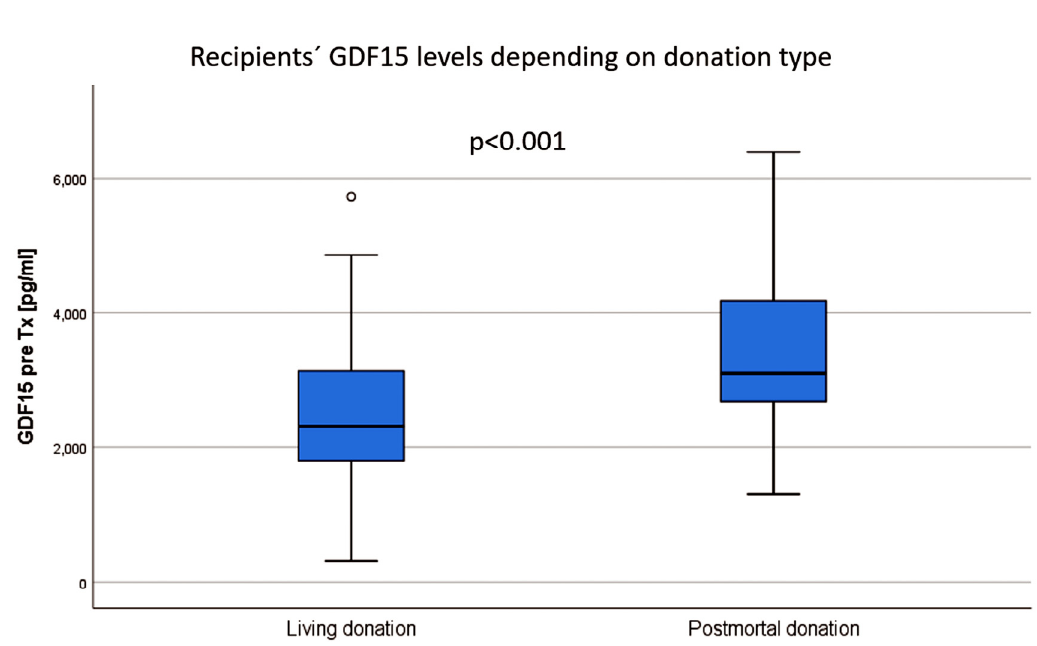
Figure 3. Association of GDF15 levels before KTx with the dialysis vintage ( A ). In congruence, GDF15 levels prior to KTx were significantly lower in end-stage renal disease patients without the need for dialysis treatment ( B ). The GDF15 values in recipients of a living donation were lower than in recipients of a postmortal donation ( C ).